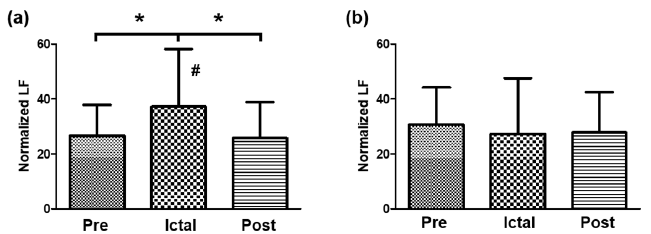
Figure 1. Comparison of normalized LF between intervals in the ( a ) FLE group and ( b ) TLE group. * Indicates significant different between intervals (pre-ictal, ictal, and post-ictal). # Indicates significant different between types (FLE and TLE) at same interval.